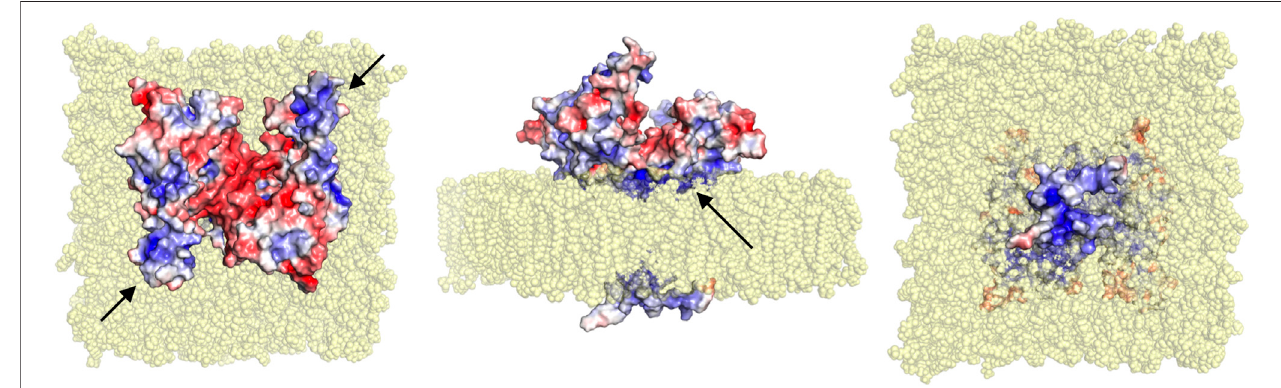
FIGURE9 | Model for full-length dimeric GDAP1 on amembrane bilayer. Full-length GDAP1, including modeled TMD and loops missing from the crystal structure, is shown as an electrostatic potentialsurface. In the top view (left), note how the cavity at the dimer interface has negativepotential, while the long helices and the ⍺ 5- ⍺ 6 loop (arrows) have positive charge. The side view (middle) shows a cavity in the dimer arrangement toward the cytosol (top) and a positively charged surface facing the membrane (arrow). The bottom view (right) indicates that the tail is very small and positively